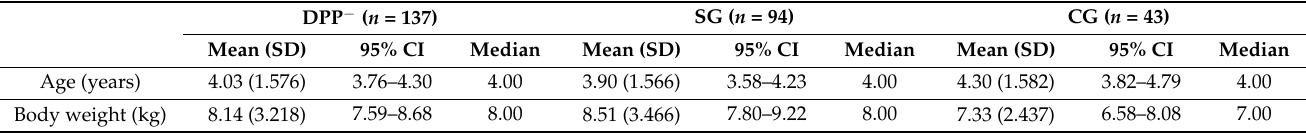
Table 2. DPP − population characterization at admission ( n =